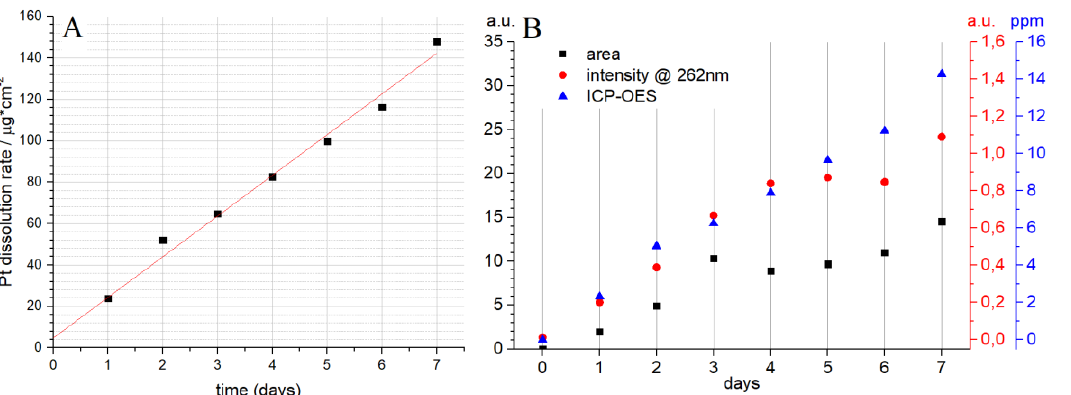
Figure 3. ( A ) Amount of platinum dissolved for each day determined by ICP-OES; ( B ) absorption intensity at 262 nm (red circles), integrated area under the peak (black squares), and the amount of dissolved Pt determine by ICP-OES (blue triangles).